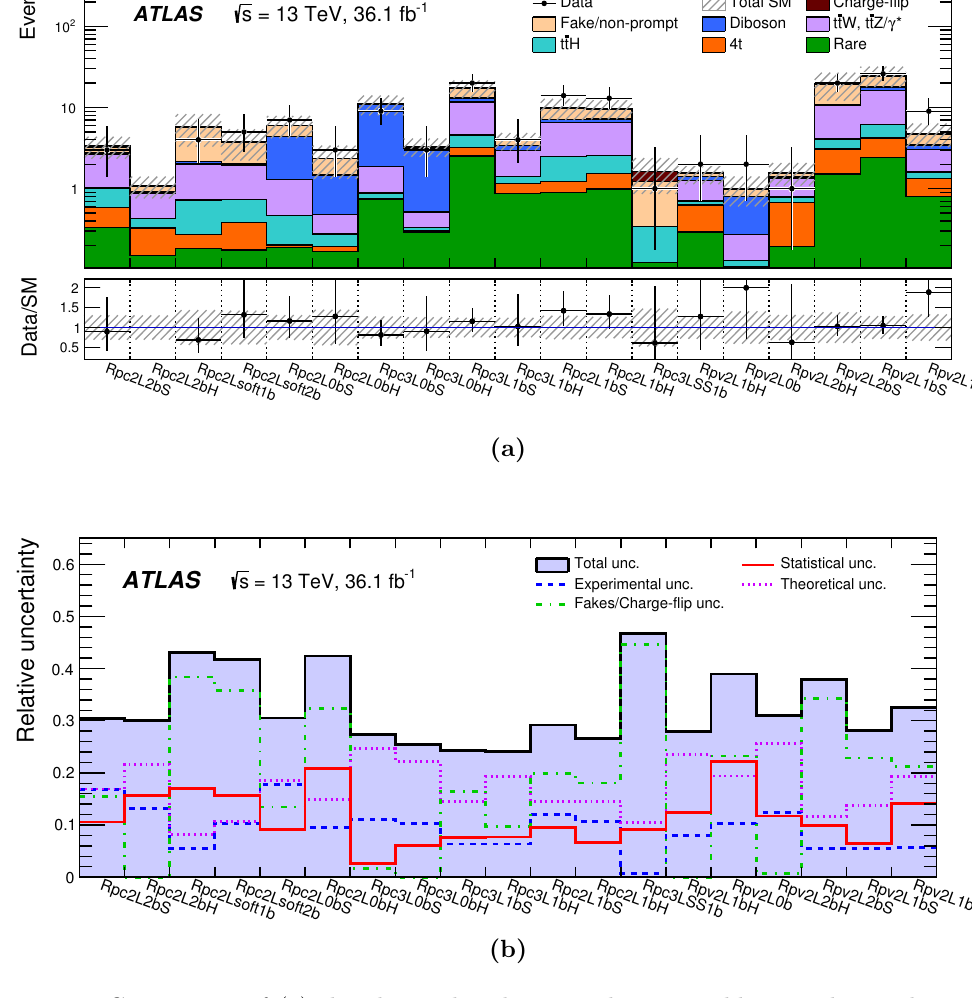
Figure 3. Comparison of (a) the observed and expected event yields in each signal region and (b) the relative uncertainties in the total background yield estimate. For the latter, \statistical uncertainty" corresponds to reducible and irreducible background statistical uncertainties. The background predictions correspond to those presented in table 5 and the rare category is explained in the